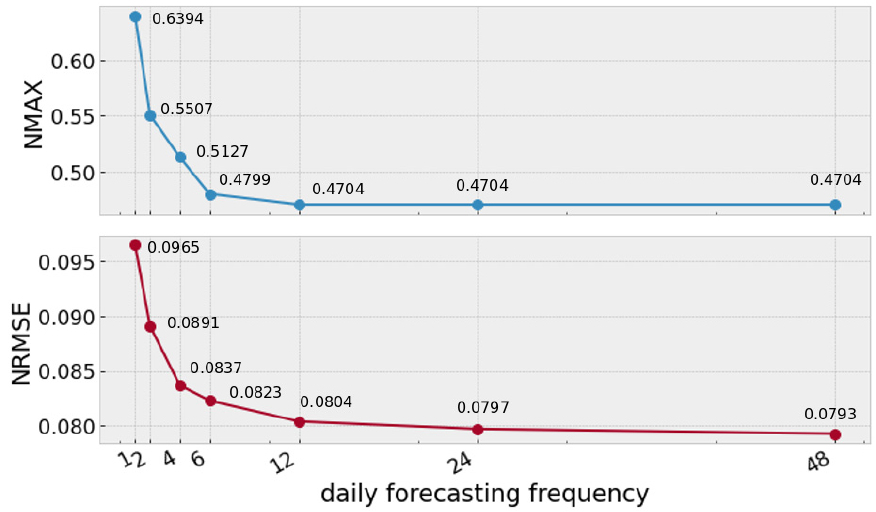
Figure 5. Daily normalized maximum error (NMAX) of GEPP on a sample week for different daily forecasting frequencies in Scenario 1.